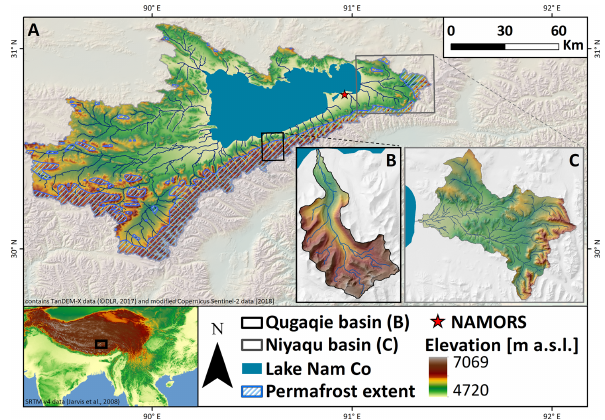
Figure 1. Overview map of the Nam Co catchment (a) including the locations of the NAMORS research station and the two main study areas: Qugaqie basin (b) and Niyaqu basin (c) . Elevation data are based on SRTM v4 (Jarvis et al., 2008) and TanDEM-X 0.4 (cid:48)(cid:48) DEM (©DLR, 2017). Permafrost extent according to Zou et al. (2017) and lake extent based on the normalized difference water index (NDWI) of Sentinel-2 optical imagery (©Copernicus Sentinel data 2018, processed by